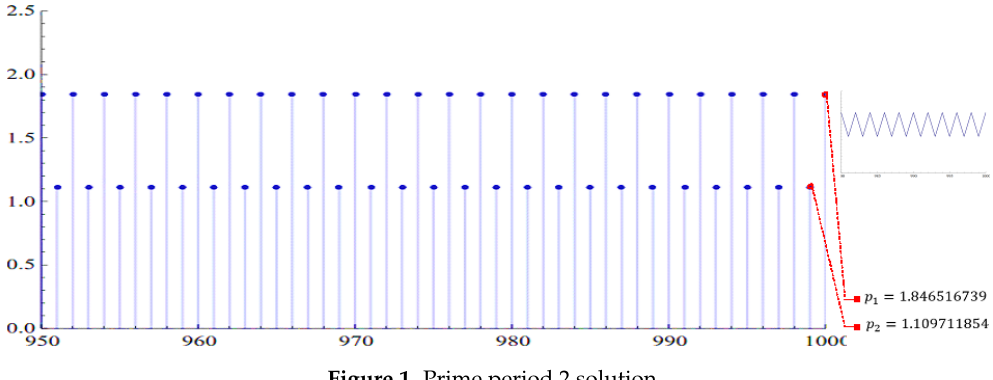
Figure 1. Prime period 2 solution.